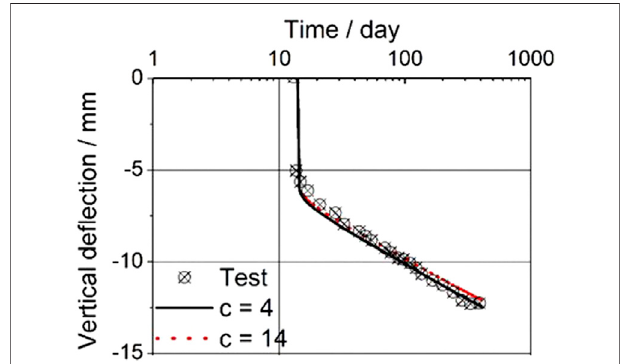
FIGURE 9 | Experimental and numerical de fl ections of specimen B2-a with different c .